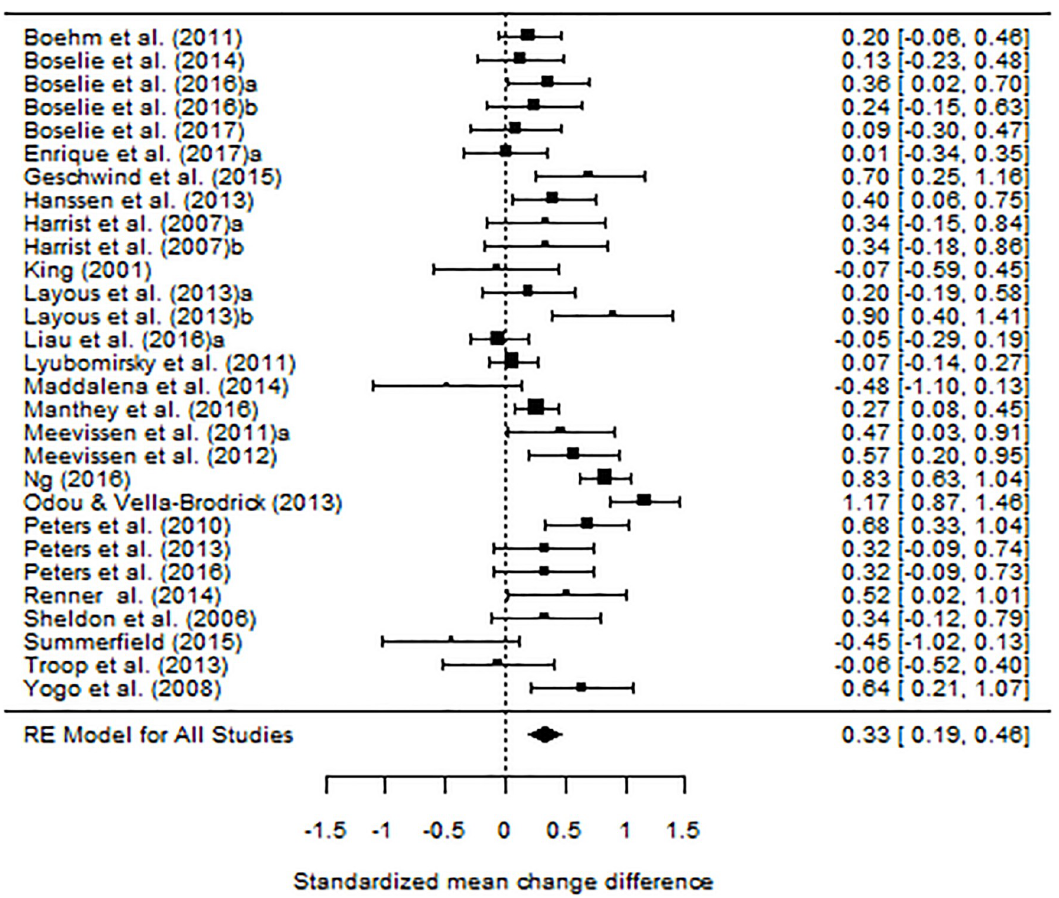
Fig 2. Forest plot displaying the effect sizes (and 95% confidence intervals) for